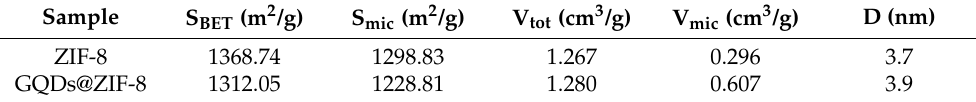
Table 1. Specific surface area and pore structure parameters of ZIF-8 and GQDs@ZIF-8.